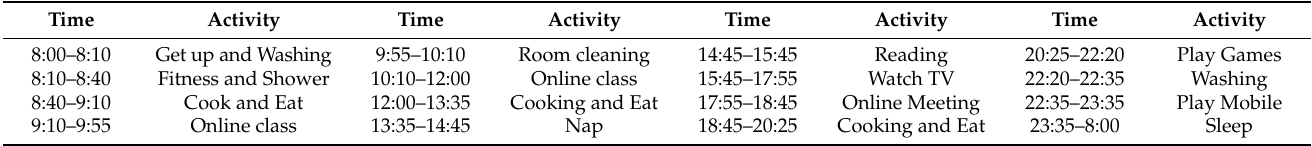
Table 2. Twenty-four hour activity record of experimenter 1.